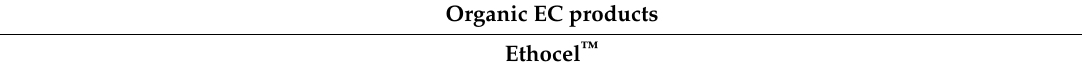
Table 1. Characteristics of commercially available EC